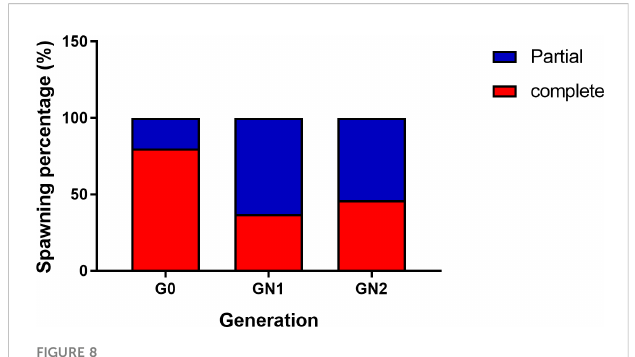
FIGURE 8 The type of spawning (complete or partial) among Penaeus indicus broodstock, G 0 (wild), G N -1 (First generation), G N -2 (Second generation) based on the chi-square analysis (X 2